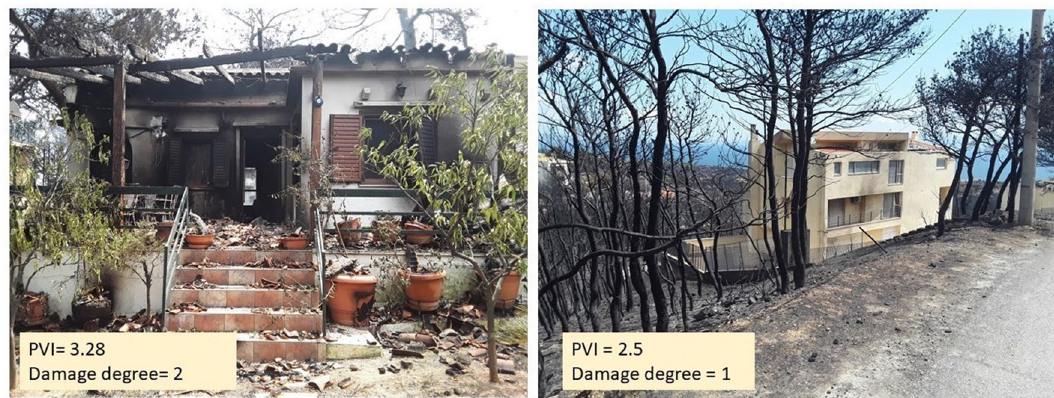
Figure 5. Burnt buildings in Mati (Photos by Michalis Diakakis and Spyridon